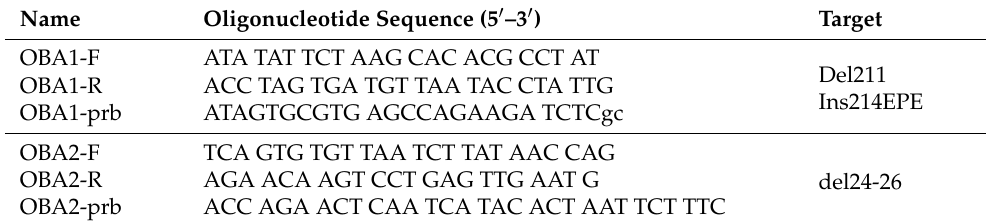
Table 1. Primers and probes for detection of Omicron